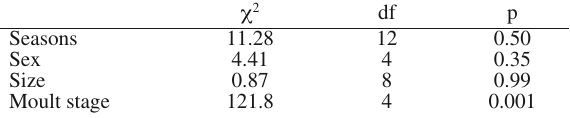
Table 1. – Summary of chi-square test of independence between stomach fullness class of spider crabs Leucippa pentagona and fac- tors: seasons, sex, size and moult stage. Chi-square statistics ( c 2 ), degrees of freedom (df) and p-value (p). Significance p<0.01.